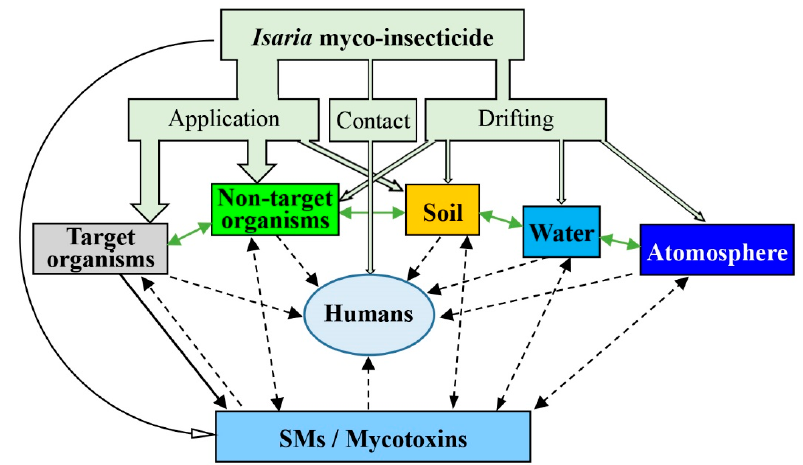
Molecules 2019 , 24 , x Figure 4. The sources and destinations of the Isaria myco-insecticide and its mycotoxins. indicates an existing pathway, while indicates a pathway that has not been found to date. (SMs = secondary metabolites) (modified based on Hu et al. (2016) [81]).